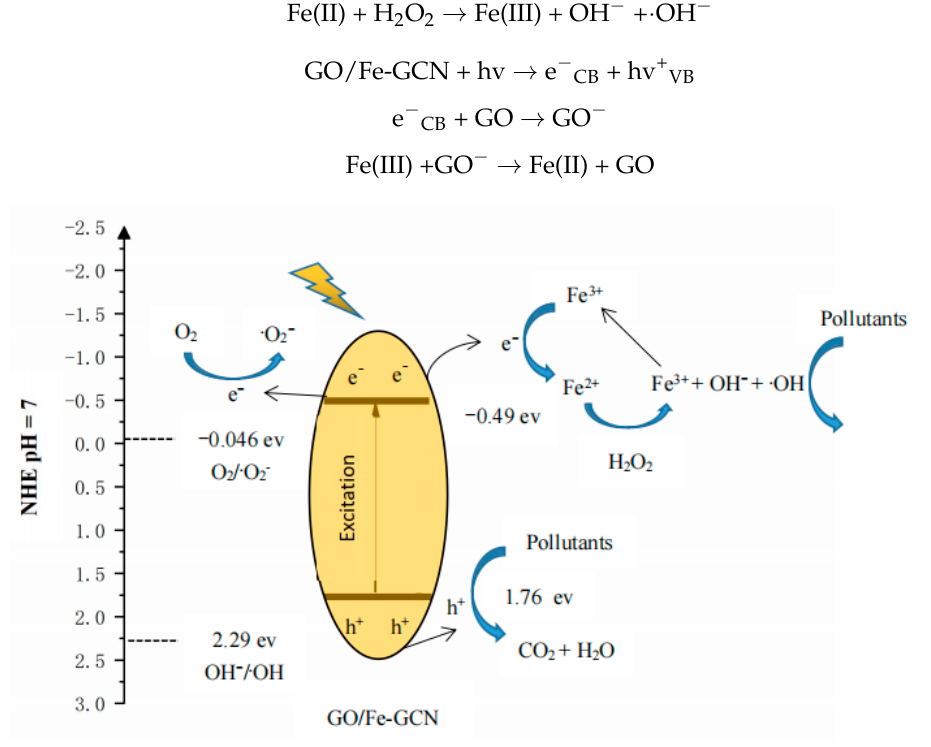
Figure 8. Photo-Fenton catalytic mechanism of GO/Fe-GCN in the reaction